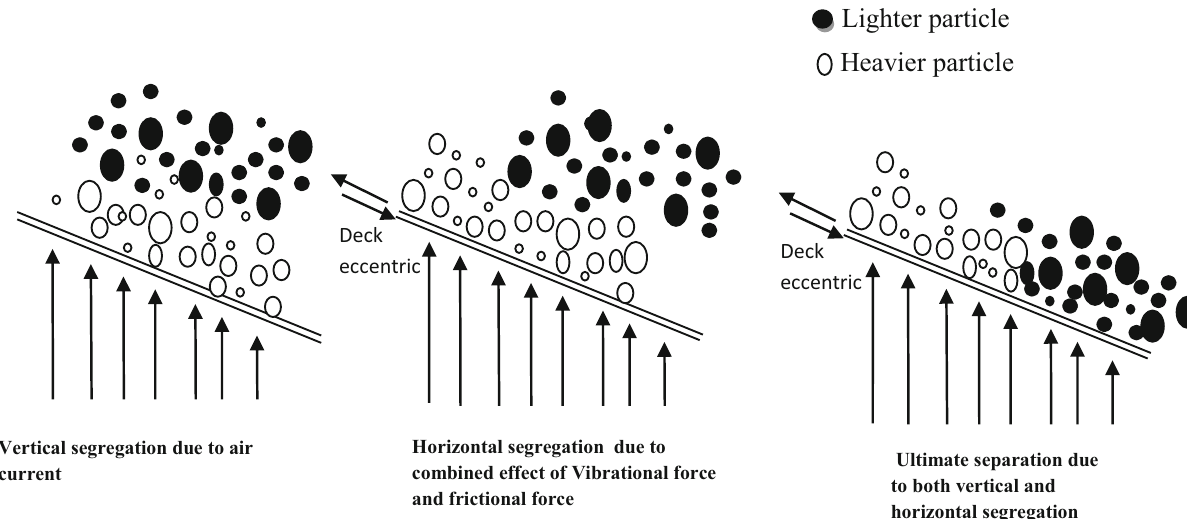
Fig. 6 Mechanism of segregation due to the combined effect of deck eccentric and airflow rate